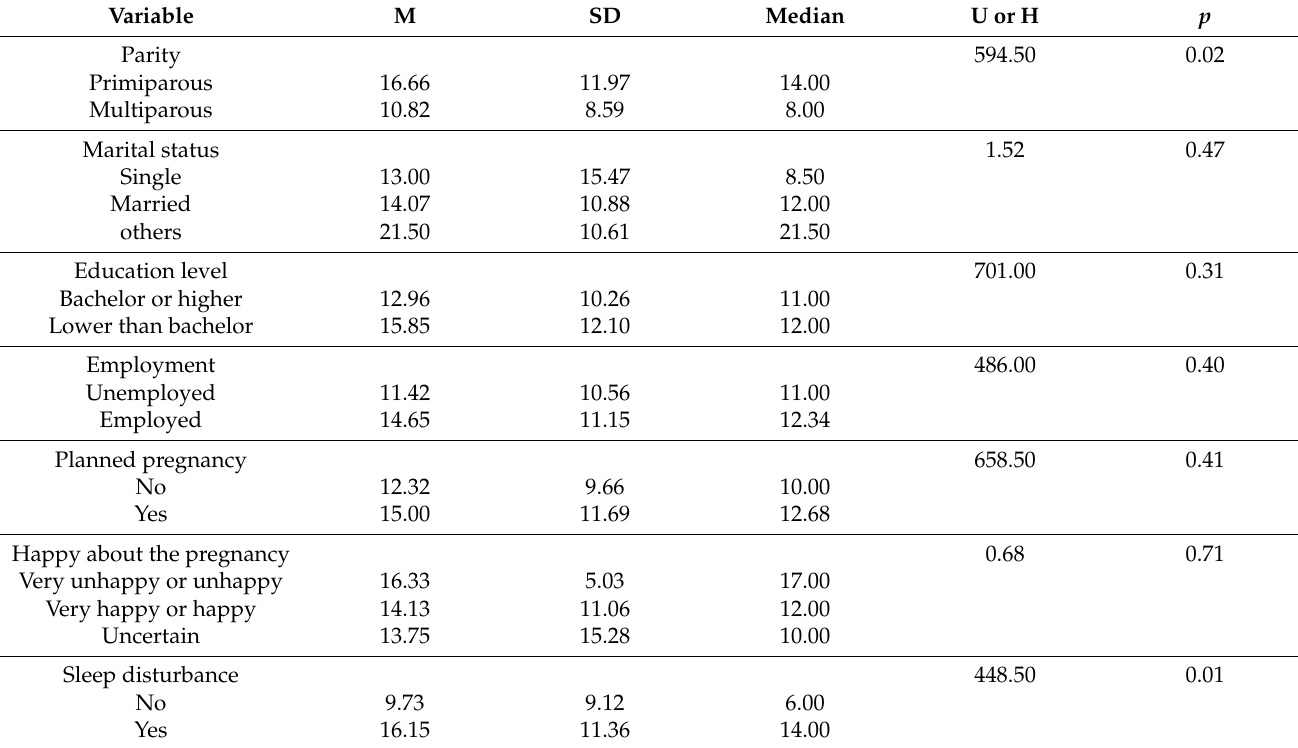
Table 5. Comparison of postpartum depressive symptoms by demographic